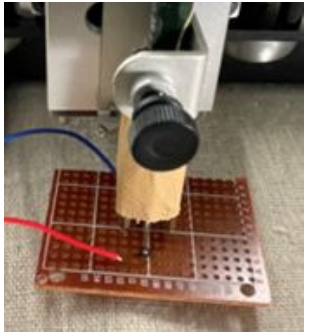
Figure 7. SMA sensor mounted on a linear plotter.